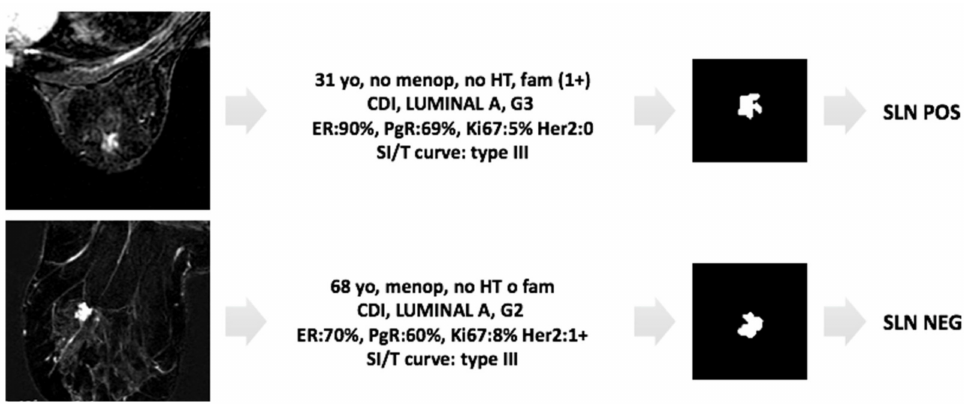
Figure 6. Example of applicability of the proposed approach. Two cases of invasive breast cancer, characterized by very similar MRI features (morphology, margin, post-contrast intensity, IS/T curve, and size and position of the two lesions are comparable) as shown in the left panels. The first case (first row) is a ductal G3 LUMINAL A carcinoma, in 31yo patient with familiarity, the second one (second row) is also a ductal G2 LUMINAL A carcinoma, but in 68yo patient without familiarity. Despite the common MRI and histological features, the produced classifier correctly categorizes the two patients as positive and negative LN status,